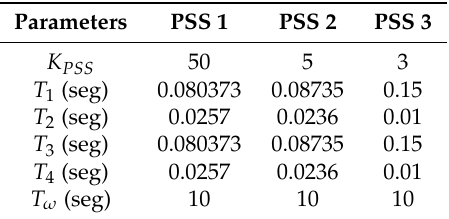
Table A4. Power system stabilizer (PSS) data for the